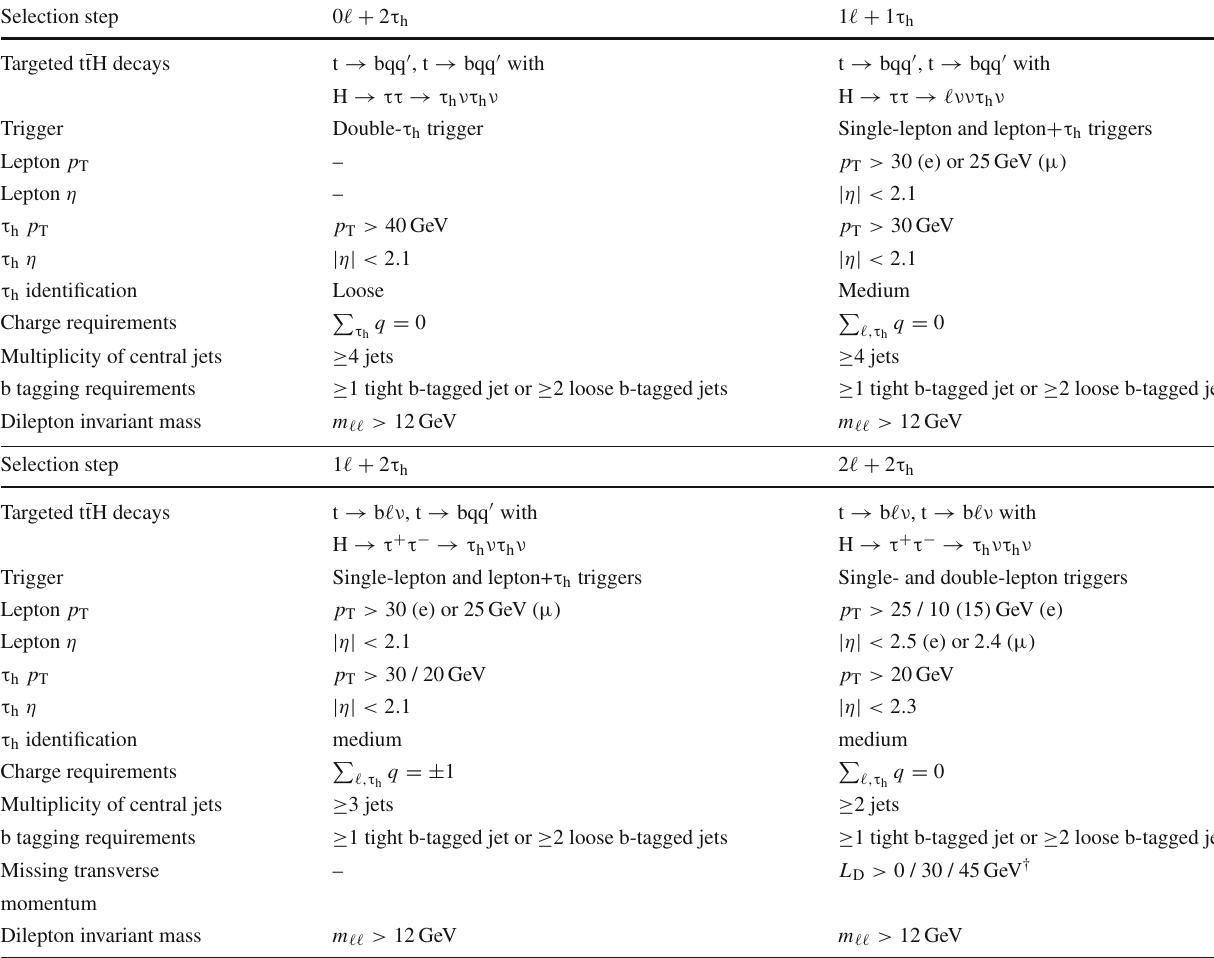
Table 3 Event selections applied in the 0 (cid:4) + 2 τ h , 1 (cid:4) + 1 τ h , 1 (cid:4) + 2 τ h , and 2 (cid:4) + 2 τ h channels. The p T thresholds applied to the lepton and to the τ h of highest and second-highest p T are separated by slashes. The symbol “–” indicates that no requirement is